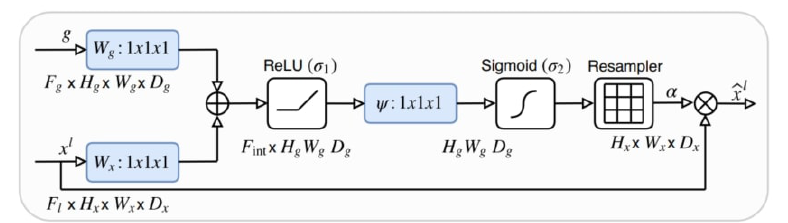
Figure 3. Attention mechanism implemented in the study